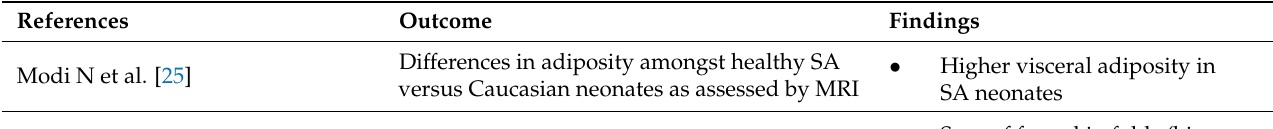
Table 2. Trends in adiposity distribution seen in those of SA